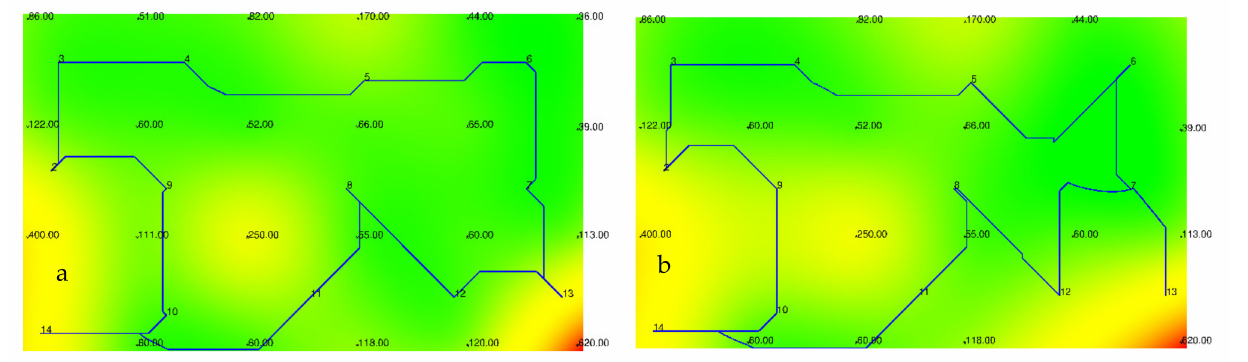
Figure 6. Optimal routes for room B using all reference values ( a ) and 80% of reference values ( b ).